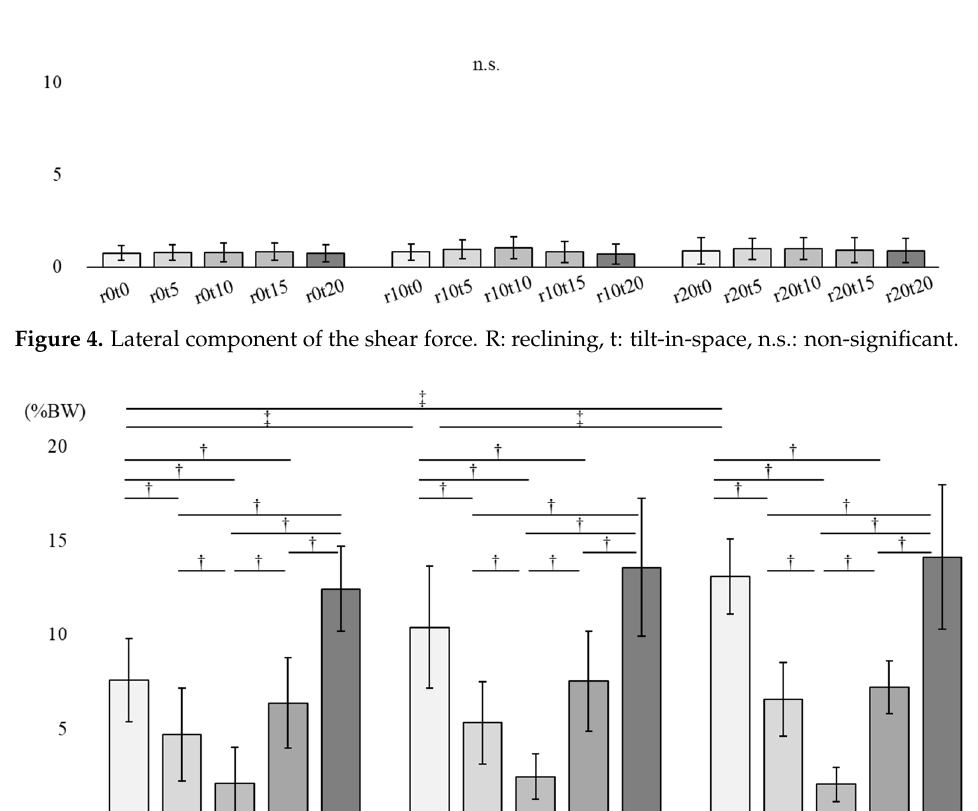
Figure 4. Lateral component of the shear force. R: reclining, t: tilt-in-space, n.s.: non-significant.